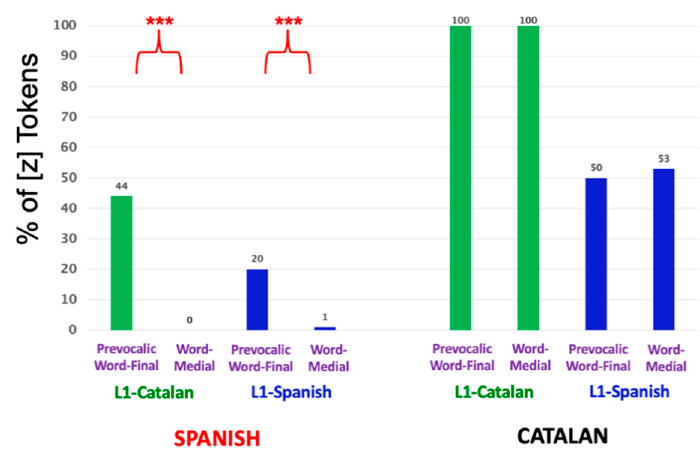
Figure 12. Effect of word position as mediated by language profile and language on Barcelonan fricative production.